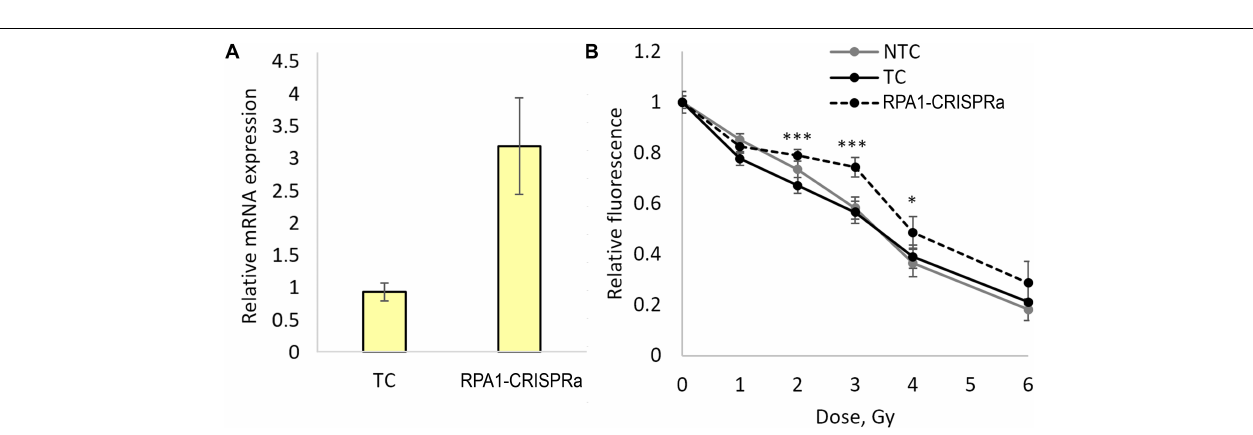
FIGURE 1 | The effect of the overexpression of the RPA1 gene on the resistance of HEK293T cells to ionizing radiation and the proliferation rate. (A,B) The levels of mRNA (qRT-PCR) and protein (western blotting) of RPA1 48 h after cotransfection of cells with the plasmids encoding the dCas9-VPR activator and guide RNAs (three biological replicates per group in each analysis). (C) The proportion of surviving CFU after exposure to γ -radiation at 3 Gy (12 replicates per group). (D) The average number of cells per coloniy (25 randomly selected colonies per group). *, differences with the TC group are significant at p < 0.05 (Student’s t -test).